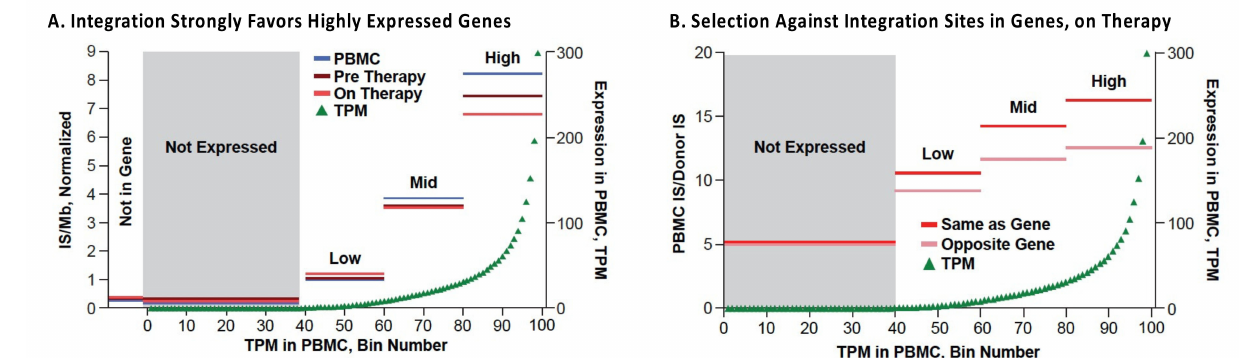
Figure 2. Distribution of HIV integration sites in genes in vitro and in vivo. The 22,000 protein- and long non-coding RNA genes in the hg19 database were divided into 100 bins based on the relative levels of the RNA in transcripts per million in PHA-stimulated donor PBMC (green triangles). ( A ) The bins were further combined into 4 groups (not-, low-, medium-, and high-expressed). The integration site (IS) density relative to total IS in PBMC infected in vitro (blue) and pre-ART (plum) and on-ART (red) donors was plotted for each expression group. ( B ) The on-ART IS data were further separated by orientation of the proviruses relative to the host gene and the data for the PBMC infected in vitro were divided the same way. Note that higher values indicate fewer integrations in the on-ART relative to the PBMC data. Reprinted from [37].